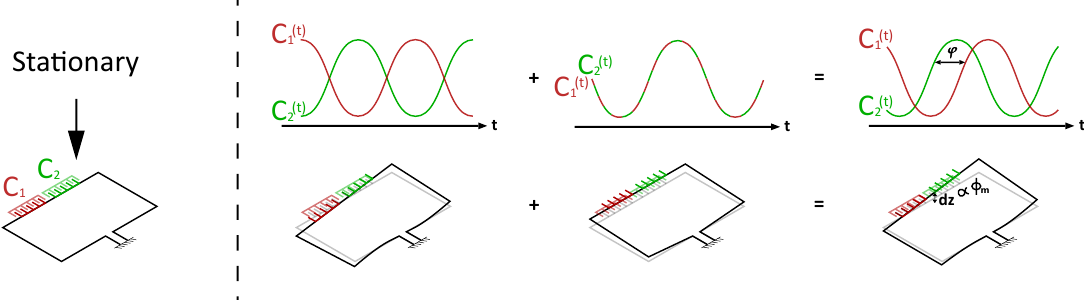
Figure 3. Operation principle of the capacitive readout. When actuated in Twist mode, the capacitance signals over time are 180 ◦ out of phase. Swing mode vibration induced by a mass flow through the channel causes common mode signals. When actuating with flow, the capacitance signals will have a phase difference ϕ dependent on the mass flow rate φ m .